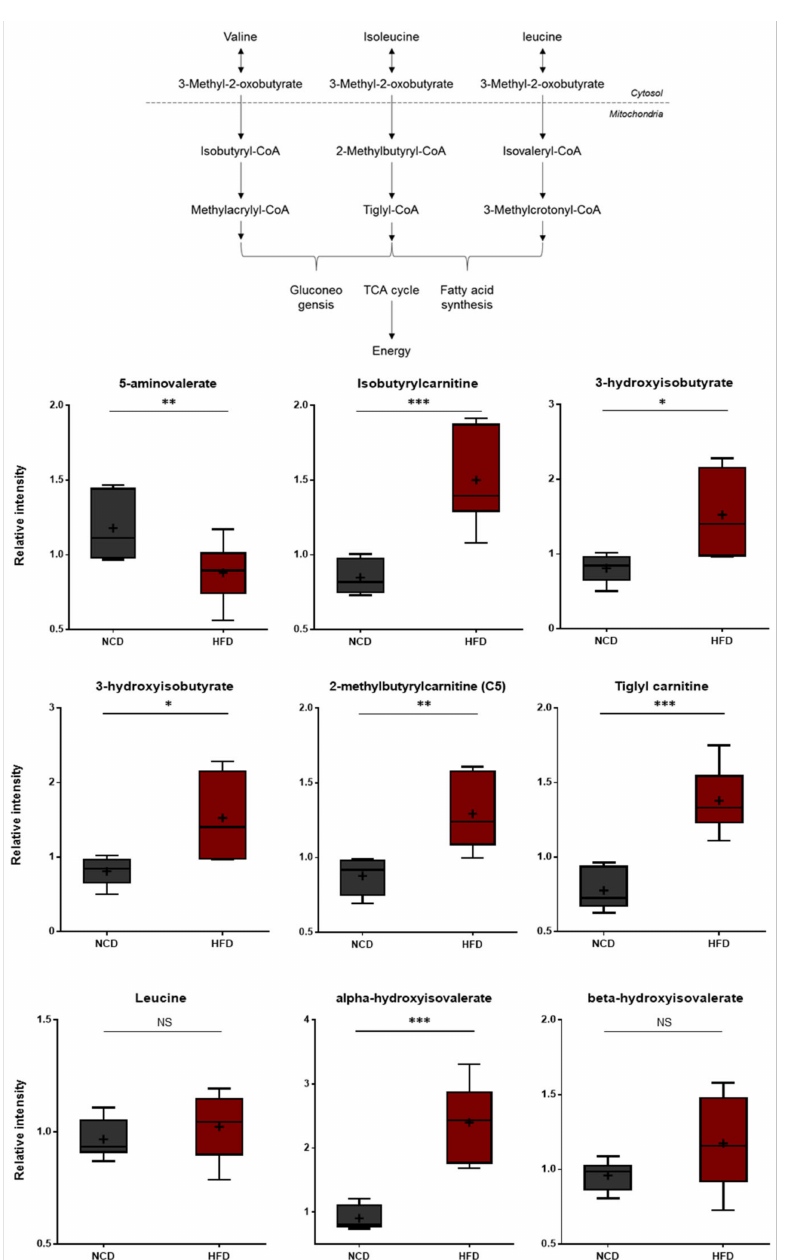
Figure 6. Pathway of statistically significant biochemicals profiled between NCD group and HFD group. Valine/Isoleucine/Leucine-Catabolites increased which present branched-chain amino acid metabolism is altered in the HFD group. Data were presented as mean ± SD ( n = 6) and two-way ANOVA with Bonferroni’s multiple comparison test. * p < 0.05; ** p < 0.01; *** p <